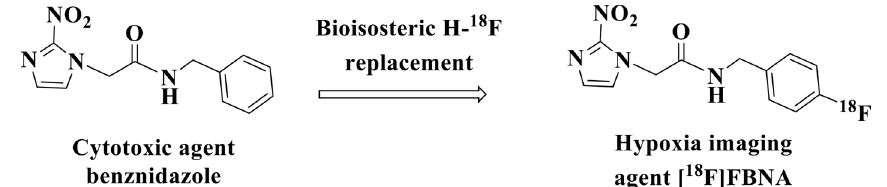
Fig. 2 Chemical structures of benznidazole and [ 18